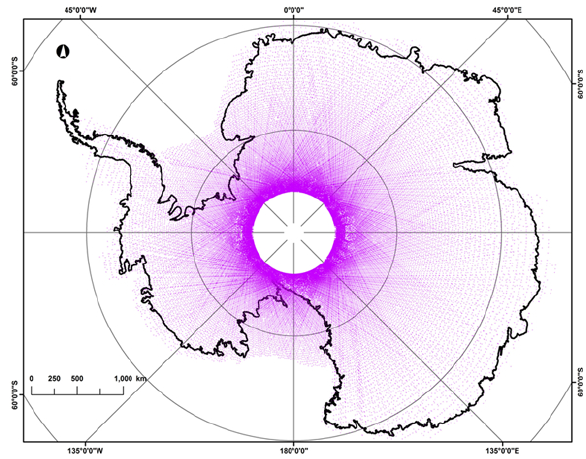
Figure 1. Location of times series locations in Antarctica gener- ated by SERAC at ICESat ground track